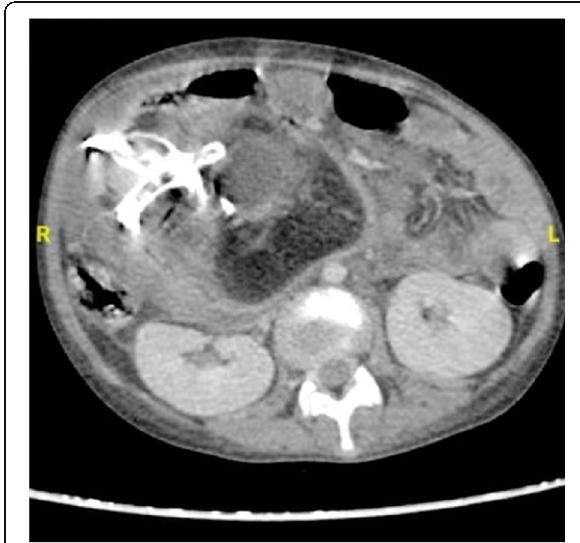
Fig. 1 CT scan of the retroperitoneal lesion showing solid and cystic components, fat attenuation, and